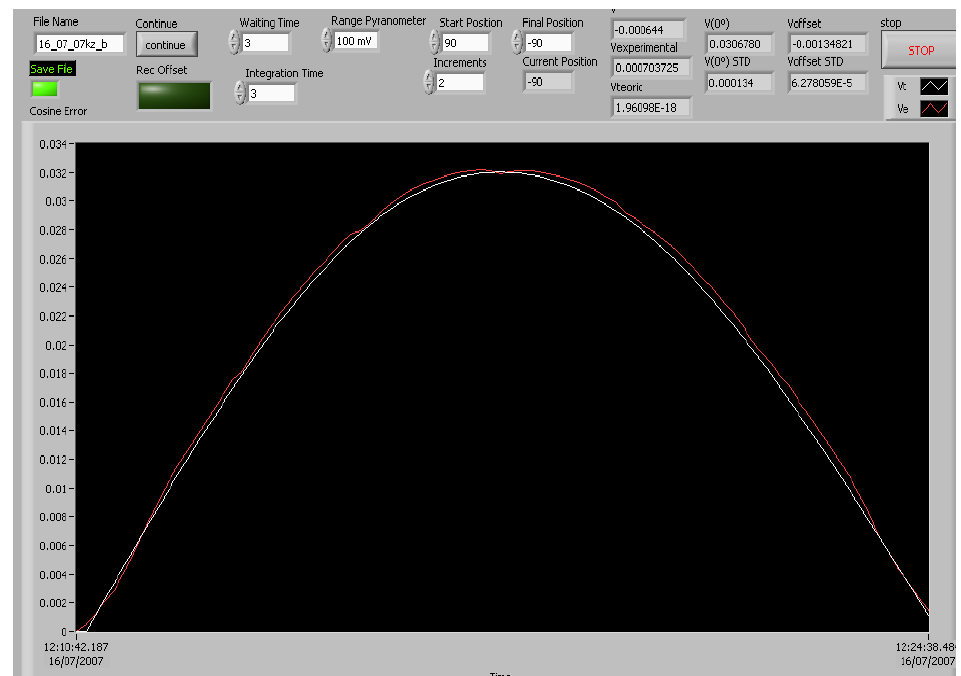
Figure 8. Ideal response and real measured response curves for a given radiometer according to the angle of